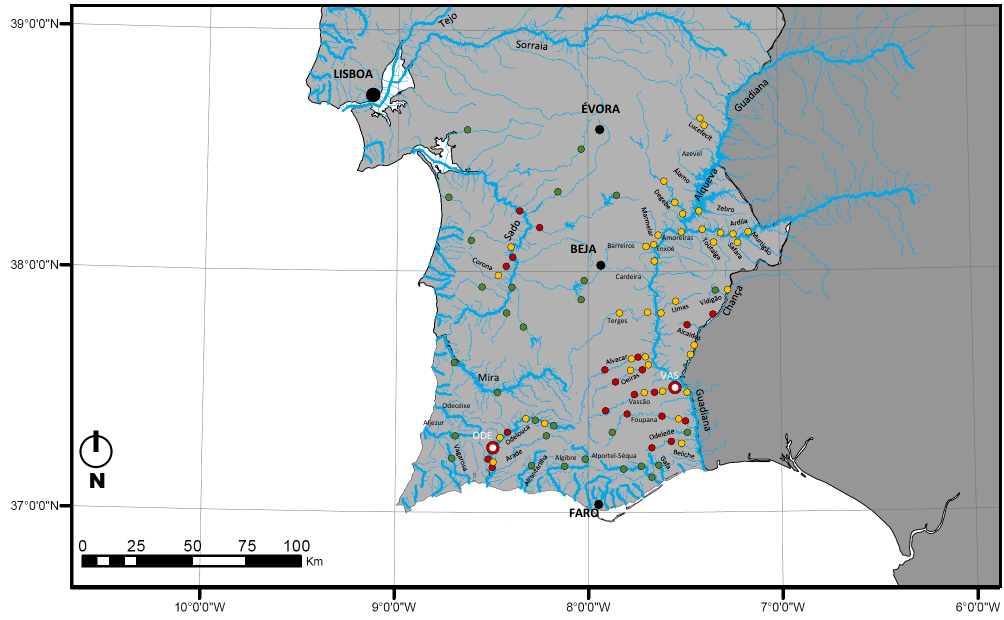
Figure 1. River drainages in southern Portugal showing the locations surveyed in the present study with presence (red) or absence (green) of Australoheros facetus . Yellow circles correspond to presence recorded in previous studies (see text). Red and white circle represent the sites used for community analysis in the Vasc ã o (VAS) and Odelouca (ODE)